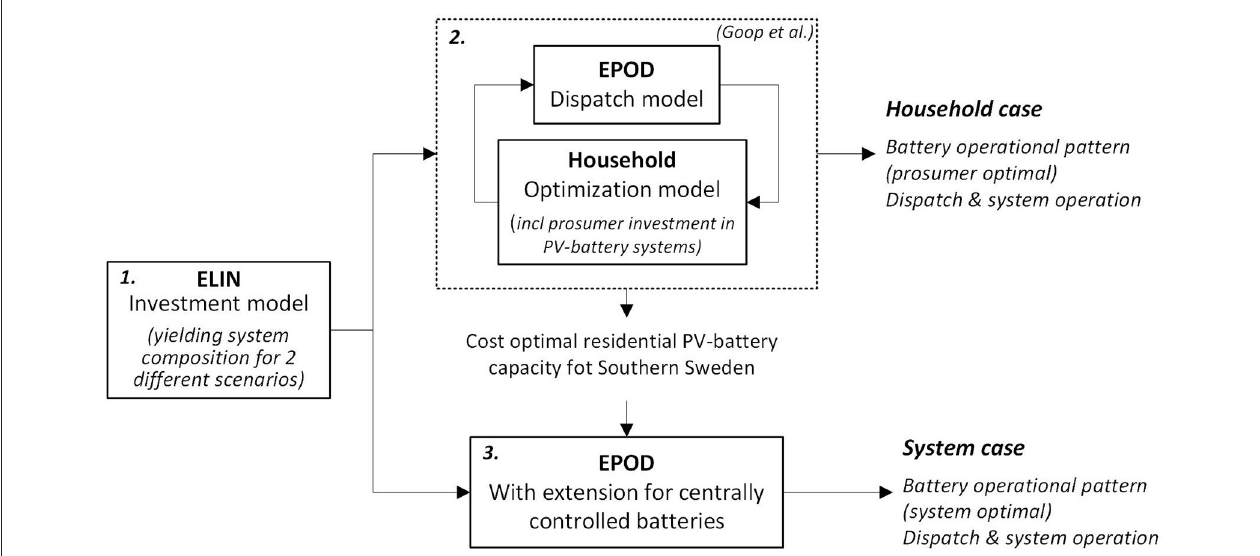
FIGURE 1 | Schematic of the modeling procedure, including the electricity generation system investment model ELIN, the iterative approach that combines the European dispatch model EPOD and a household annual cost-optimization model [developed by Goop et al. (submitted), see also (Goop, 2017)], and the EPOD model, which is further extended to represent centrally controllable battery capacity.